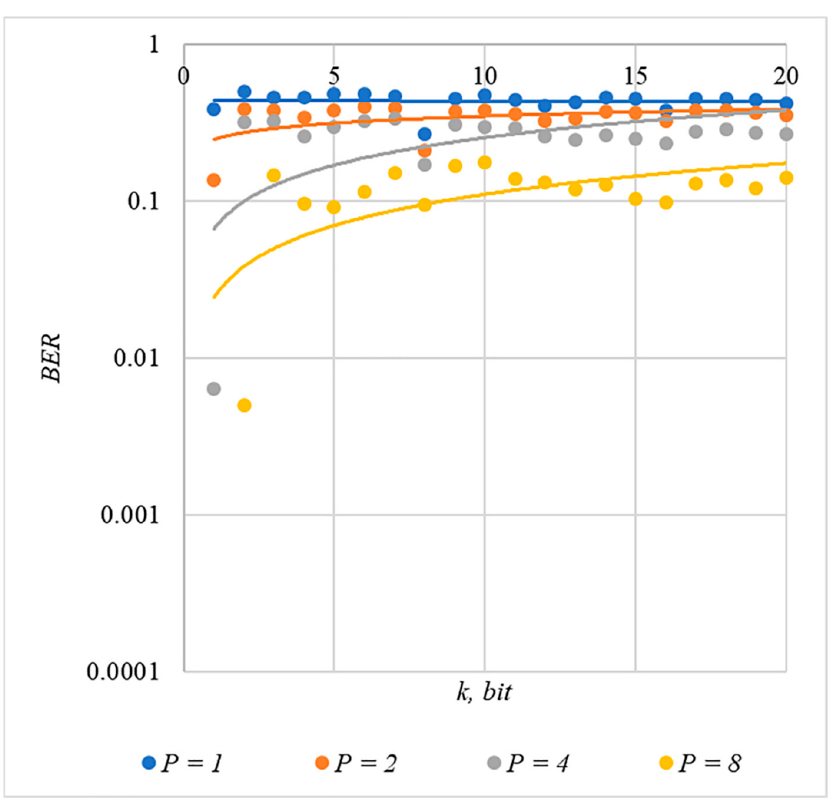
P rule for generating chip codes № 1.